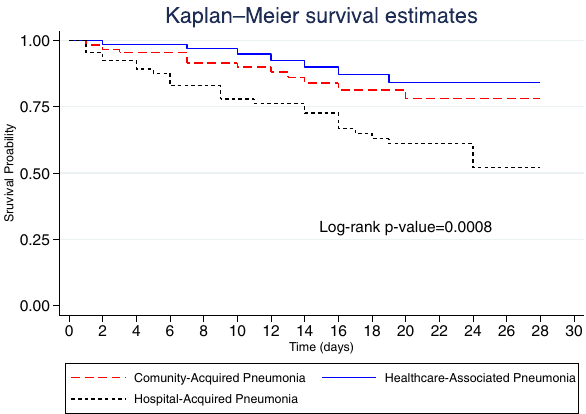
Figure 2. Kaplan–Meier graph of 28-day mortality by pneumonia category.